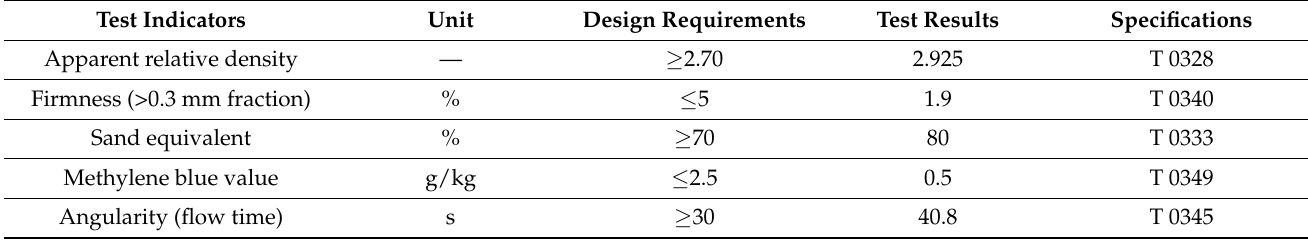
Table 4. Fine aggregate test